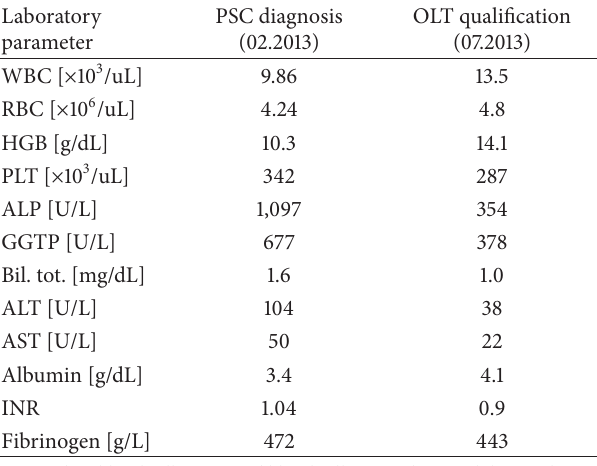
Table 1: Laboratory tests results on PSC diagnosis and on OLT qual-